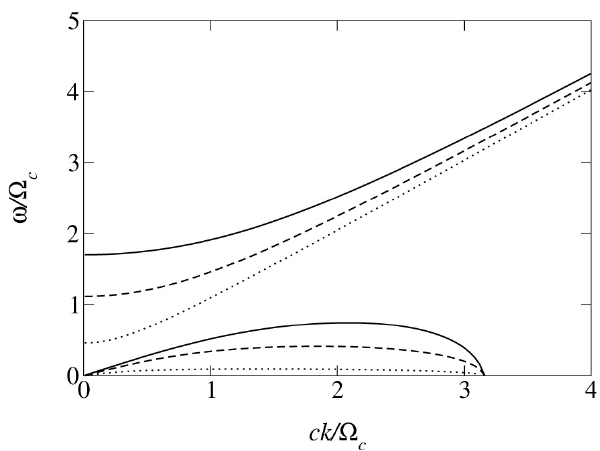
Fig. 1. Electromagnetic and Alfvén branches for the general disper- sion relation, Eq. (21), for a = 1, α = 0 . 1. Solid line: cold plasma case ( f = 1); dashed line: f = 2; dotted line: f = 10.